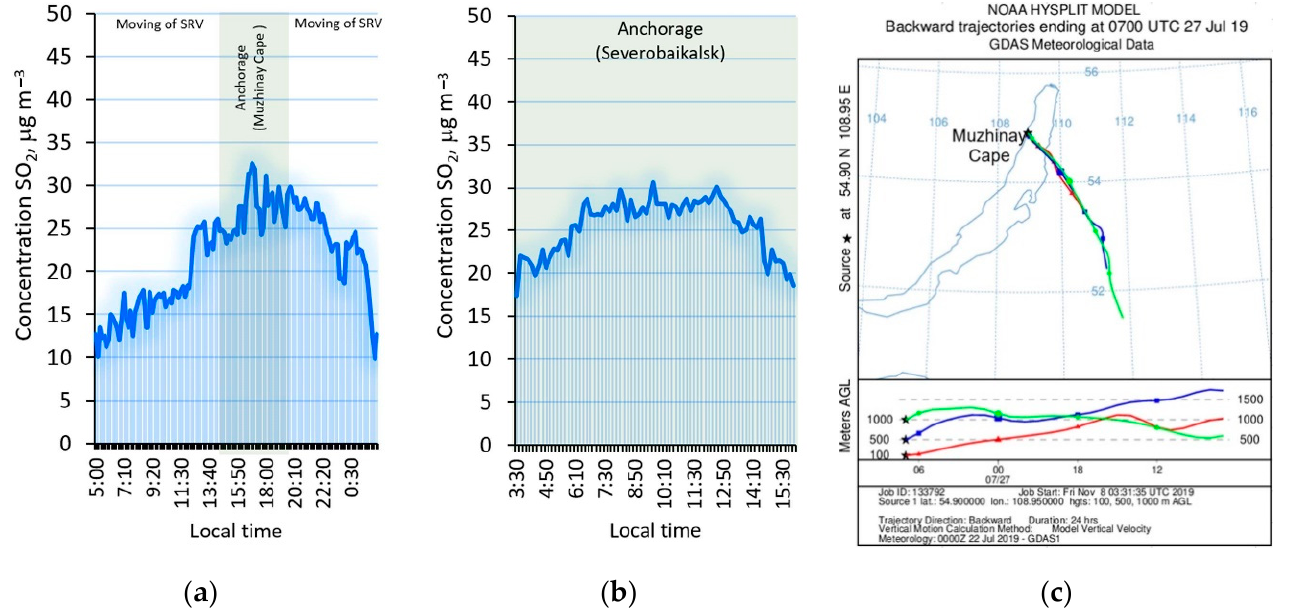
Figure 7. Temporal variation of concentration of sulfur dioxide in the Lake Baikal water layer: Cape Muzhinai (27 July 2019) ( a ); Severobaikalsk (28 July 2019) ( b ); backwards trajectories of air masses transfer (28 July 2019) the paths for the transfer of air masses trajectory at three altitude levels: 100 m (red color), 500 m (blue color) and 1000 m(green color) ( c ).